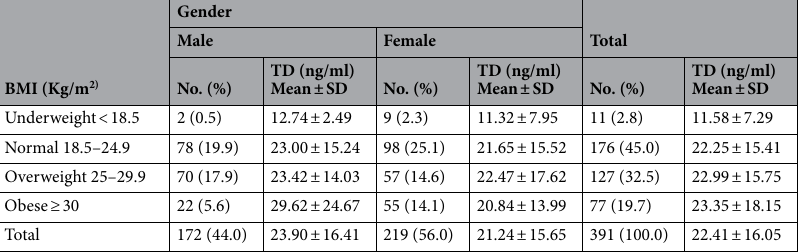
Table 5. Mean and standard deviation of Total 25-OHD level in respect to BMI. P-value = 0.620.